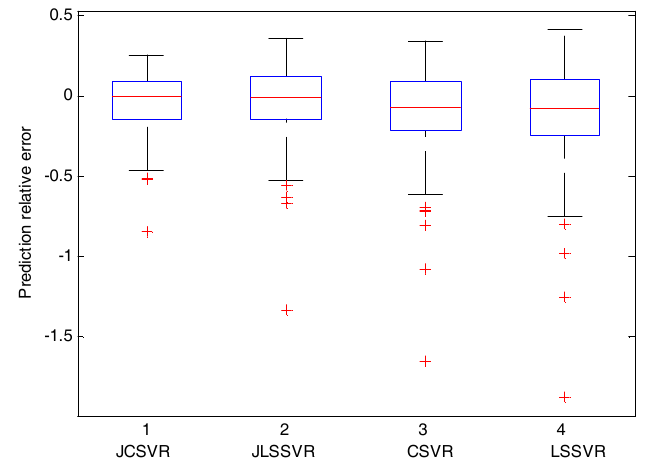
Figure 7. Comparison results of silicon content prediction relative error distribution with JCSVR, JLSSVR, CSVR, and LSSVR models (test set).